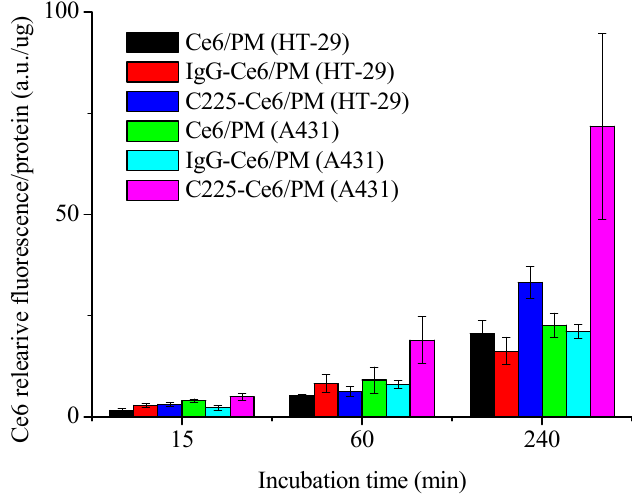
Figure 2. The quantitative fluorescence levels of Ce6/PM, IgG-Ce6/PM, and C225-Ce6/PM taken up